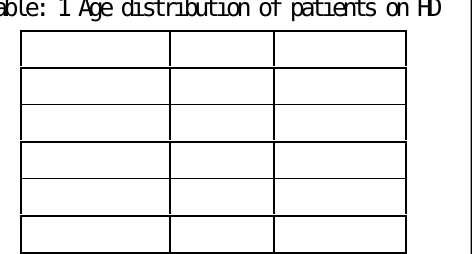
Table: 1 Age distribution of patients on HD